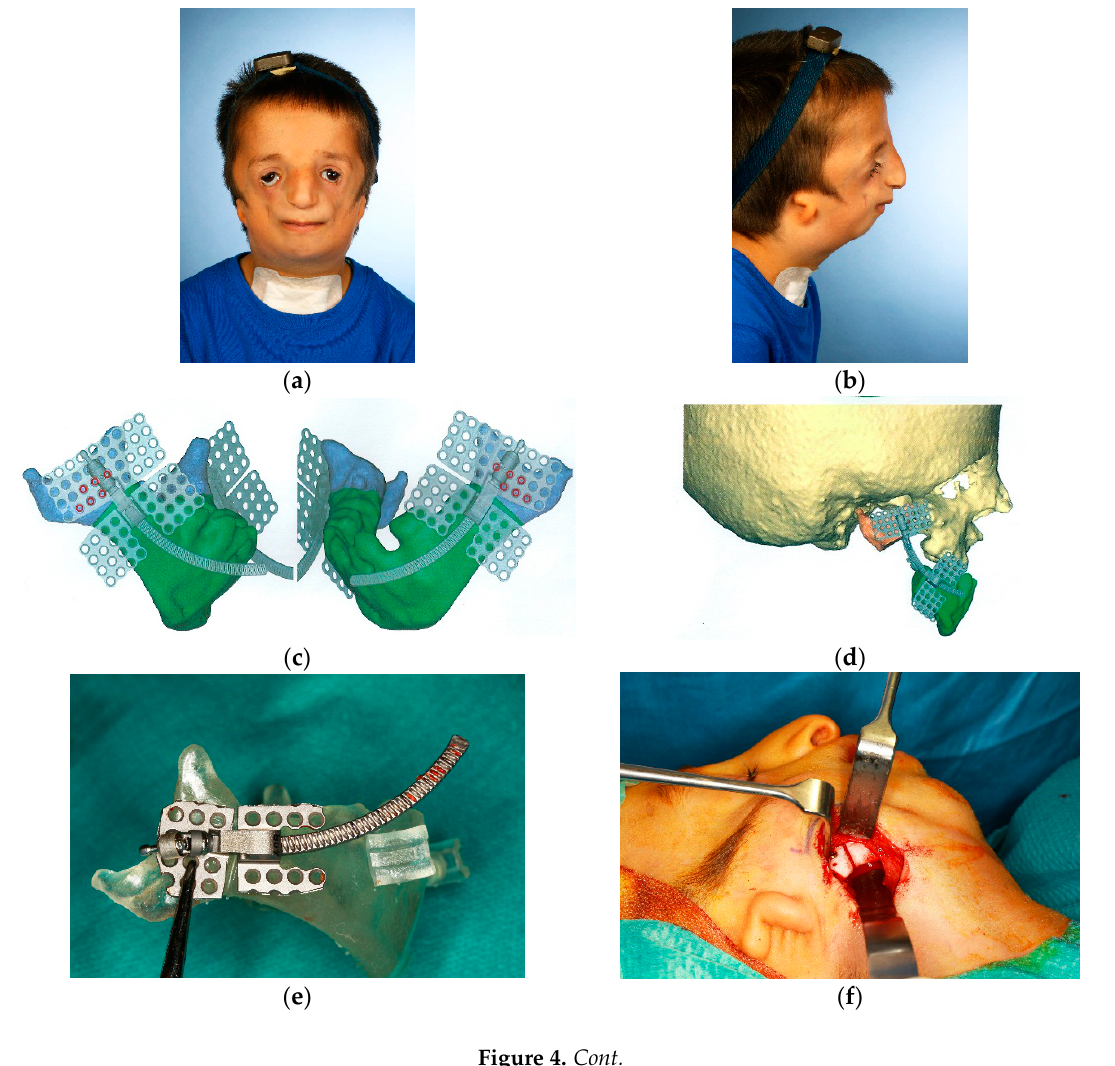
Figure 4. Cont. Figure 4.